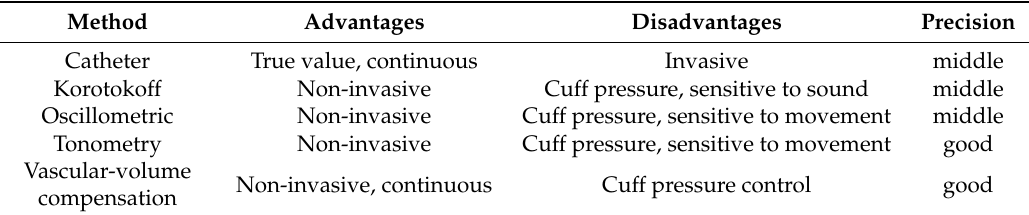
Table 1. Comparison of the methods of blood pressure measurement [24,25].